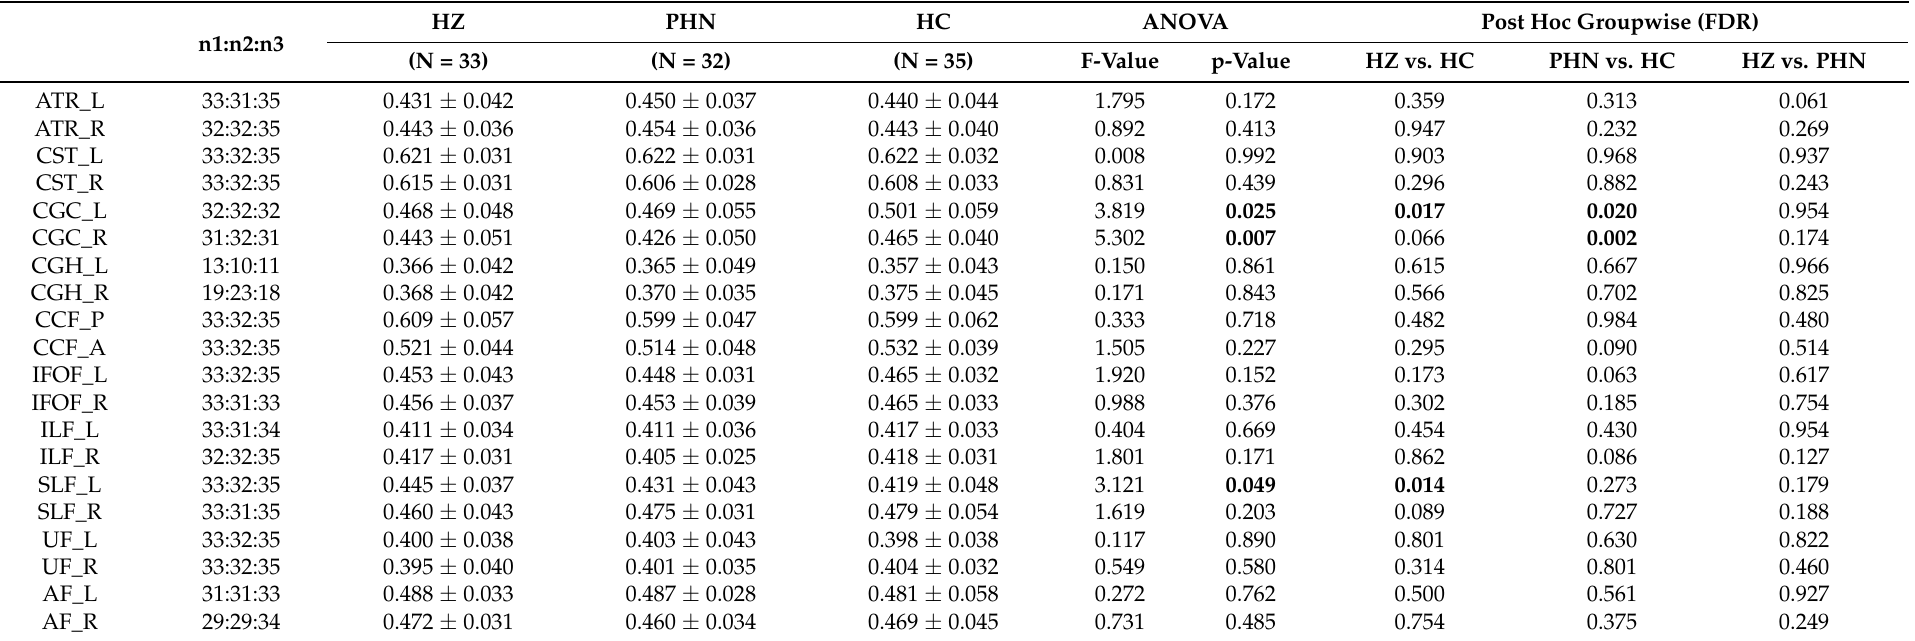
Table 2. Comparison of mean FA among the three